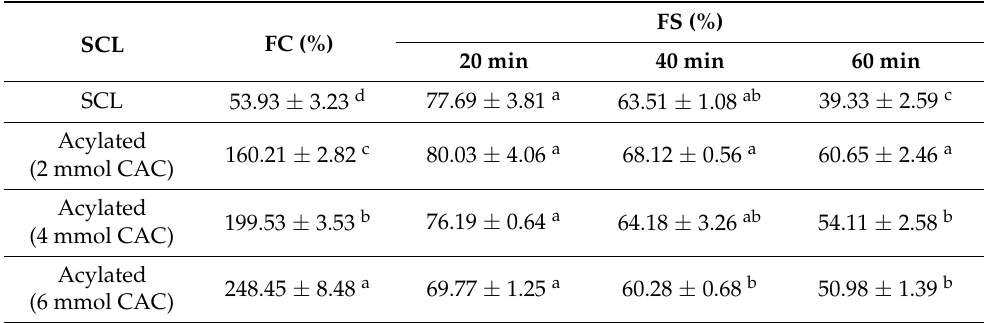
Table 2. Effect of secalin (SCL) lipophilization with increasing capric acid chloride (CAC) on protein foaming capacity (FC) and foam stability (FS)